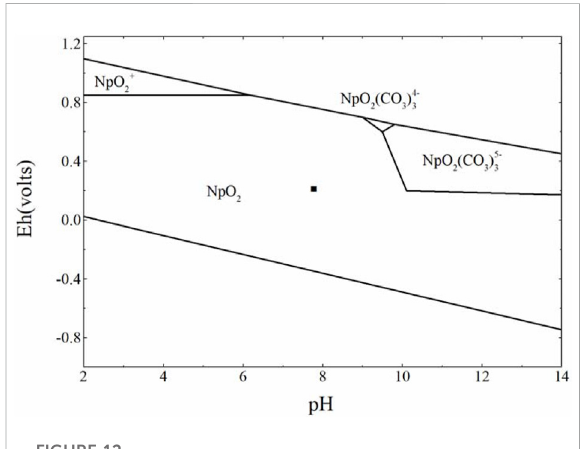
FIGURE 12 Eh-pH diagram of [Np]tot = 10 − 4 mol L − 1 under the groundwater taken from the Gansu proposed-treatment plant area.